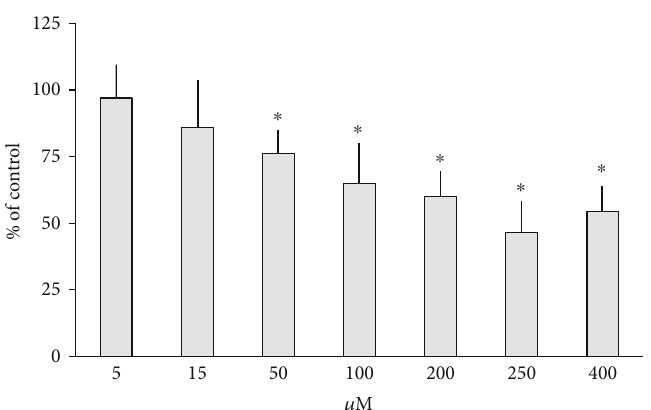
Figure 1: The in fl uence of losartan (LOS) on the kynurenic acid (KYNA) production in rat brain cortical slices. The data are presented as a percentage of control values. ∗ p < 0 : 05 vs. control (ANOVA with the adjustment of p value by the Bonferroni method).